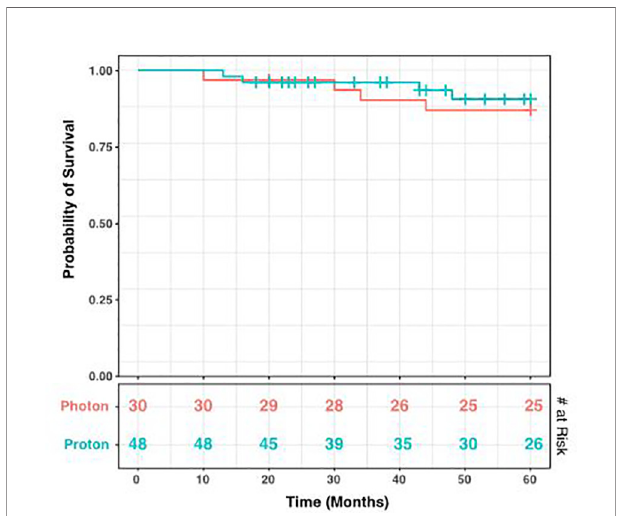
FIGURE 5 | Kaplan-Meier Curve for Survival Strati fi ed by Radiation Type. Over a 60-month period after radiation, there was no signi fi cant relationship detected between radiation type and mortality. The log rank test gives a p- value of 0.61. The number at risk at each time point is shown in the bottom